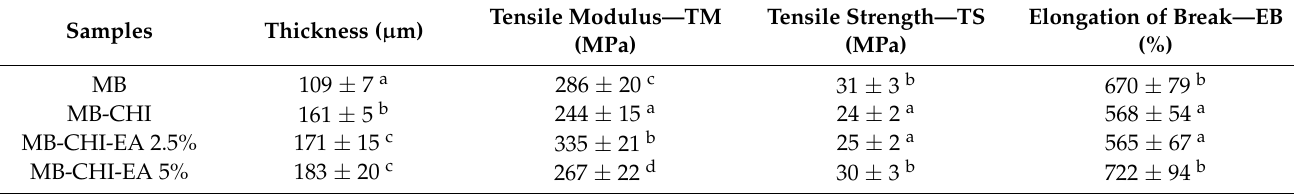
Table 1. Mechanical properties for the different samples